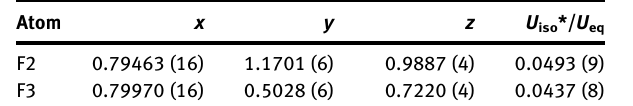
Table  : Fractional atomic coordinates and isotropic or equivalent isotropic displacement parameters (Å 